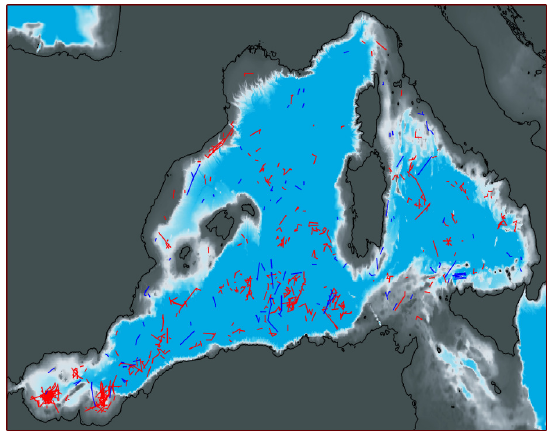
Figure 6. Tracked movements of AC (red arrows) and C (blue arrows) eddies in the Western Mediterranean